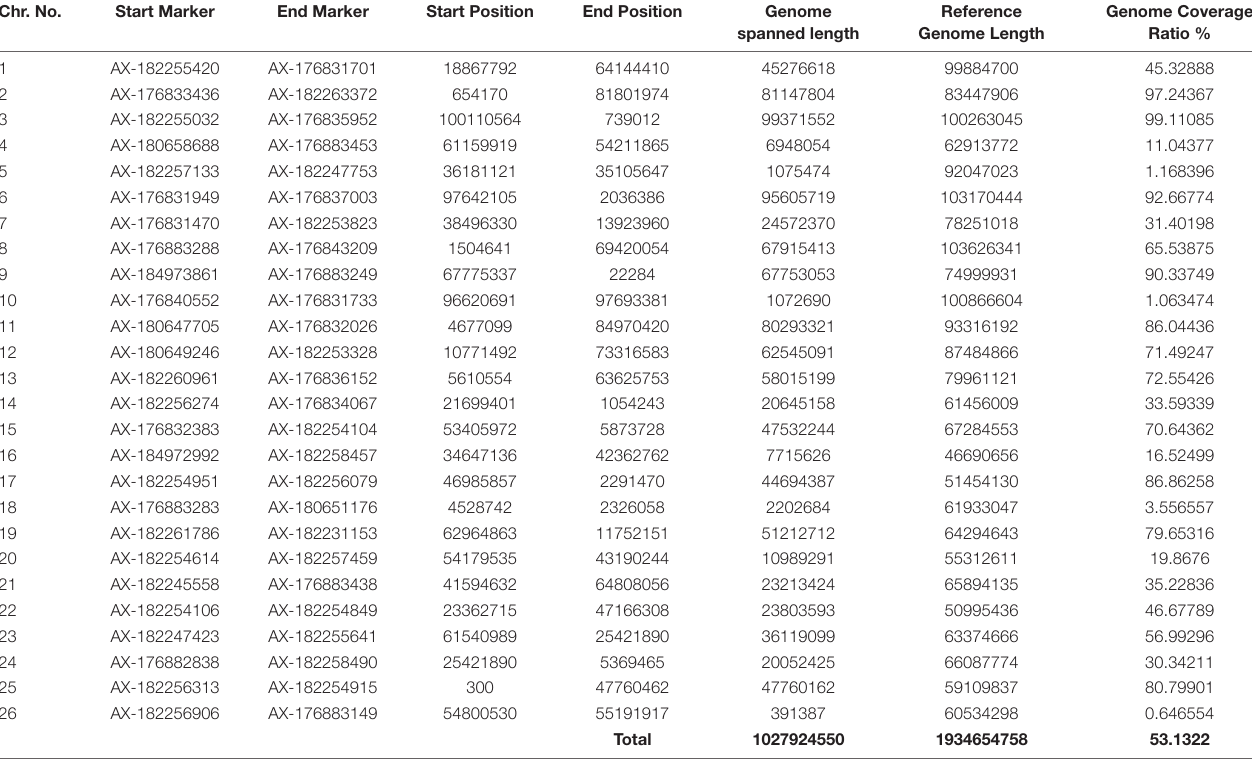
TABLE 5 | Collinearity analysis of the genetic map developed in the current study with a physical map of TM-1 Genome NAU-NBI Assembly v1.1 and Annotation v1.1 database. Chr.